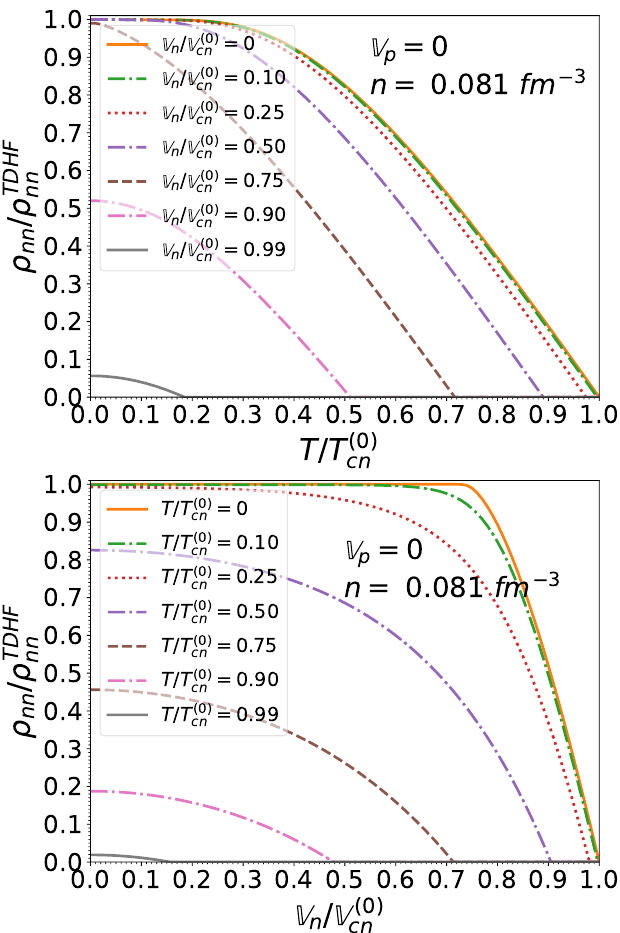
Figure 12. Dimensionless entrainment matrix element ρ nn / ρ TDHF nn as a function of the normalized ( 0 ) effective superfluid velocity V n / V cn and the normalized temperature T / T beta-equilibrium at the crust-core interface and for V p = 0.